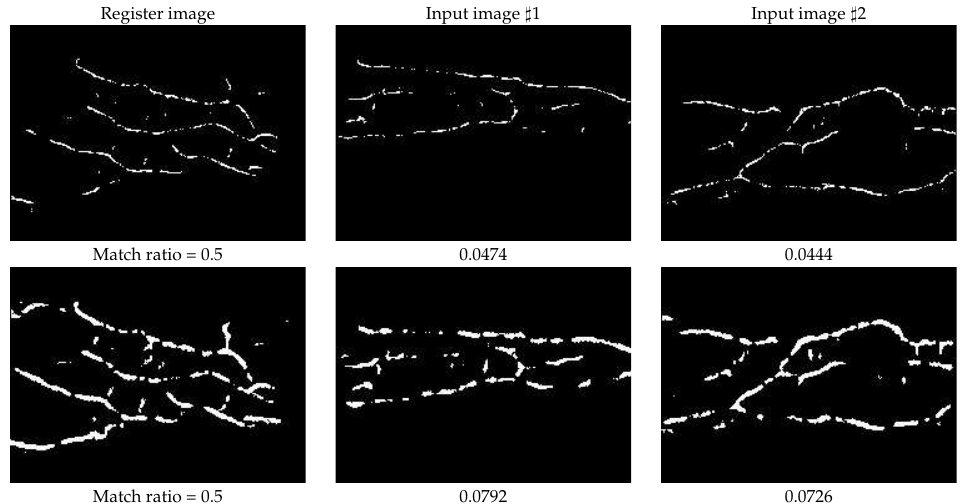
Figure 7. The match ratio of inter-class, that means the registered template and the input image are from different finger classes. The first row shows the results of mean curvature method, and the second row shows the results of our proposed RLF-based method. Their corresponding match ratios are listed below the